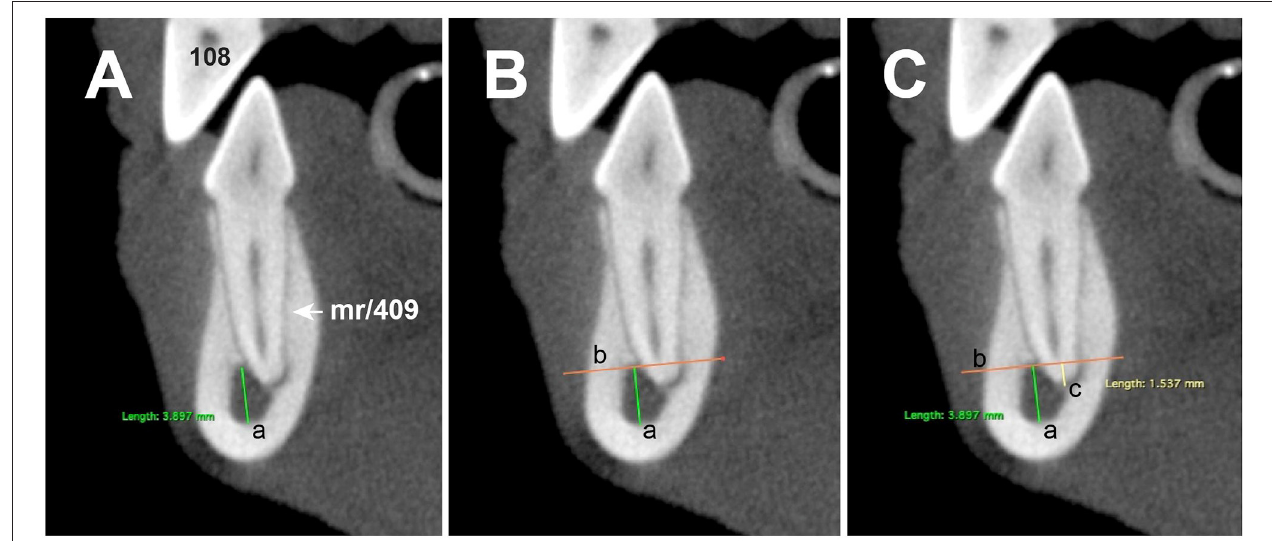
FIGURE 3 | Transversal cone-beam computed tomography (CBCT) reconstructions showing how the superimposition percentage was obtained. (A) Line-a parallel to the axis of the M1 root is drawn to determine the diameter of the mandibular canal (MC). (B) Line-b is drawn perpendicular to line-a at the dorsal margin of the MC transecting the portion of the root that would appear superimposed with MC in a dental radiograph. (C) Line-c corresponds to amount of root superimposed.